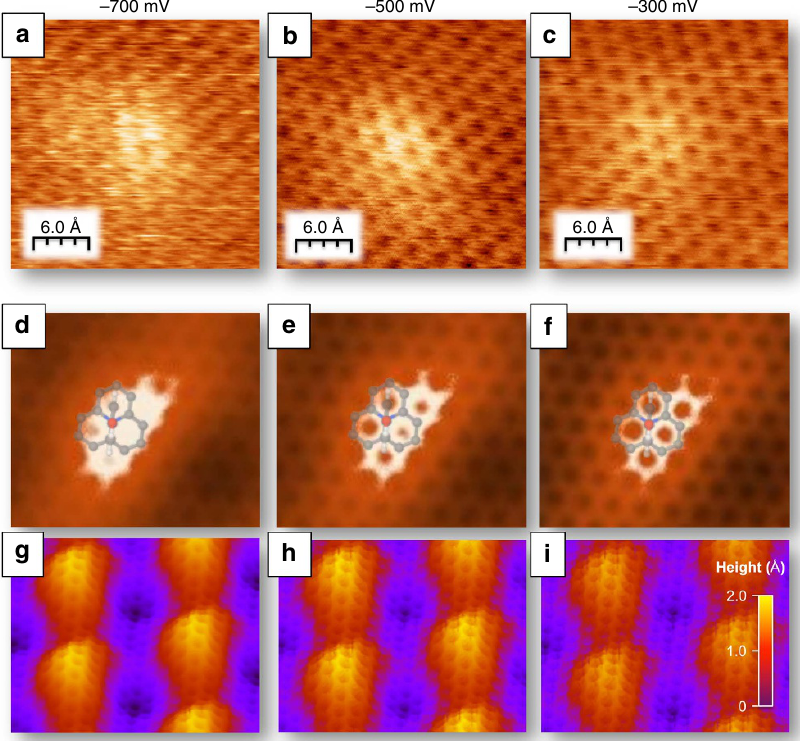
Figure 2 | The p-AP molecule replaces substitutionaly a carbon atom with the nitrogen. Series of experimental and theoretical STM images showing the dependence of the image morphological shape with the applied tunnelling bias for V s ¼ (cid:2) 700, (cid:2) 500 and (cid:2) 300mV at constant-current regime. ( a – c ) Experimental images; ( d – f ) Theoretical STM images; ( g – i ) Theoretical 3D topographical STM images. The experimental results are well